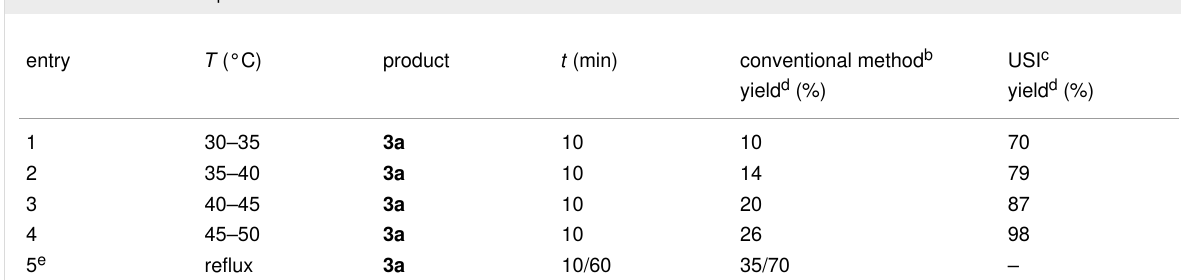
Table 4: Effect of the temperature.